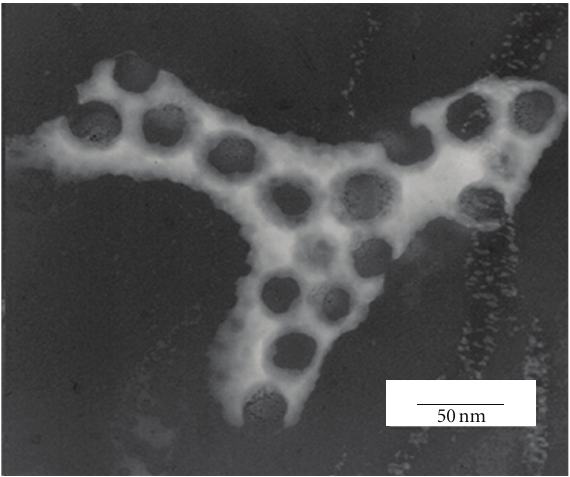
Figure 3: TEM micrographs of sample BPM10.